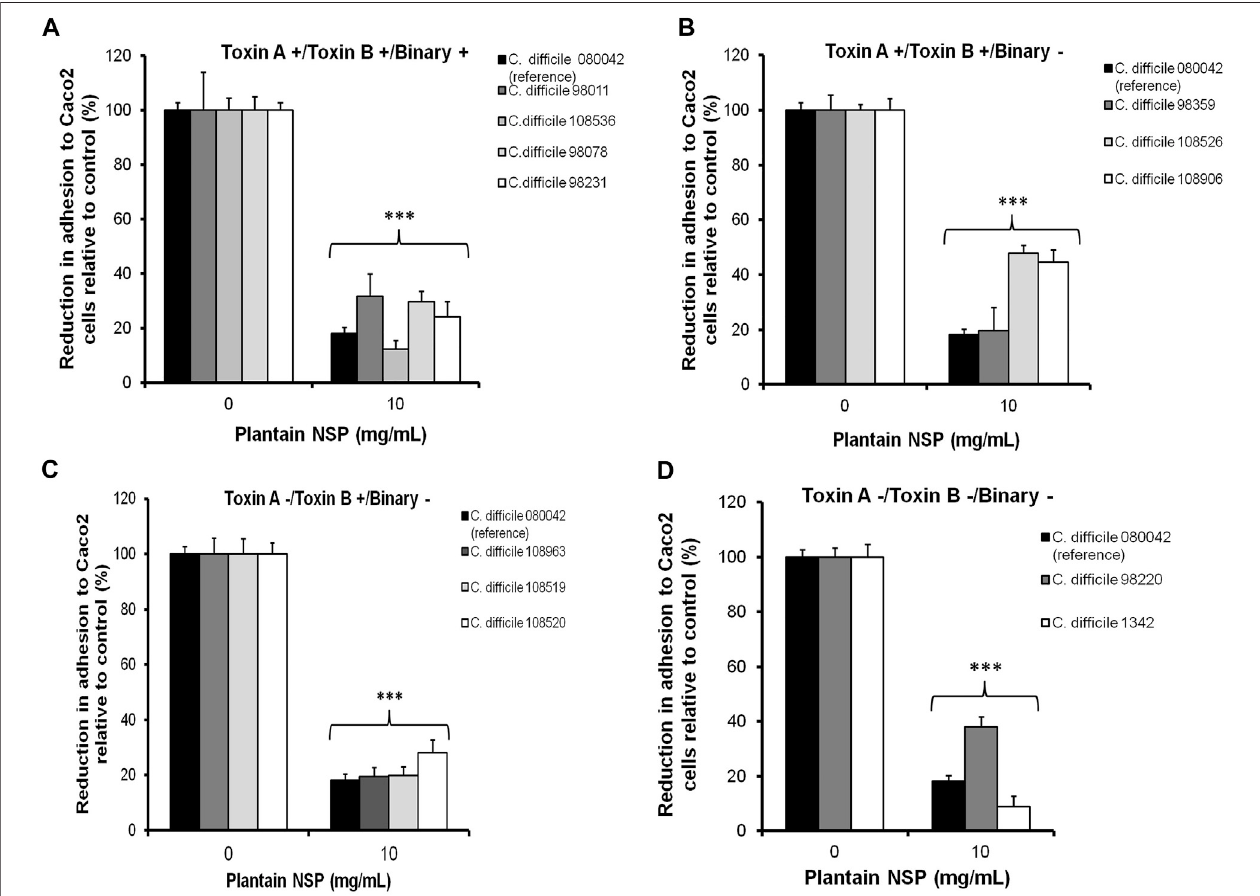
FIGURE 2 | Soluble NSP from plantain inhibits the epithelial adhesion of a panel of C. dif fi cile clinical isolates differing in toxin expression and ribotype. Caco-2 [Caco2] cells underwent pre-treatment with 10 mg/ml plantain NSP for 30 min prior to inoculation with C. dif fi cile at a multiplicity of infection (MOI) of 100. Plantain NSP signi fi cantly inhibited adhesion to Caco-2 cell monolayers, of C. dif fi cile clinical isolates positive for (A) all toxins (A, B and binary), (B) positive for toxin A and toxin B, (C) Toxin B only, and (D) toxin null strains. Clinical laboratory C. dif fi cile isolate 80042 (ribotype 027) was used as a positive reference for plantain NSP inhibition of bacteria-epithelial cell adhesion, with adhesion to Caco-2 cells expressed relativeto CFU/mL found in each untreated control (set as 100%). Signi fi cant differencesfrom untreated control, *** p < 0.001, N (cid:2) 3 experiments, n (cid:2) 3 replicates; Kruskal-Wallis